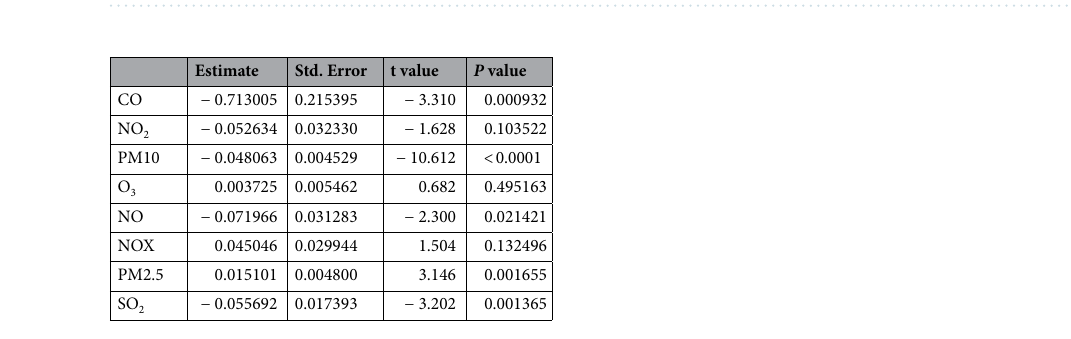
Figure 3. Negative relationships between certain pollutants and rain occurrence using full year dataset. Rain occurrence is measured as presence/absence.